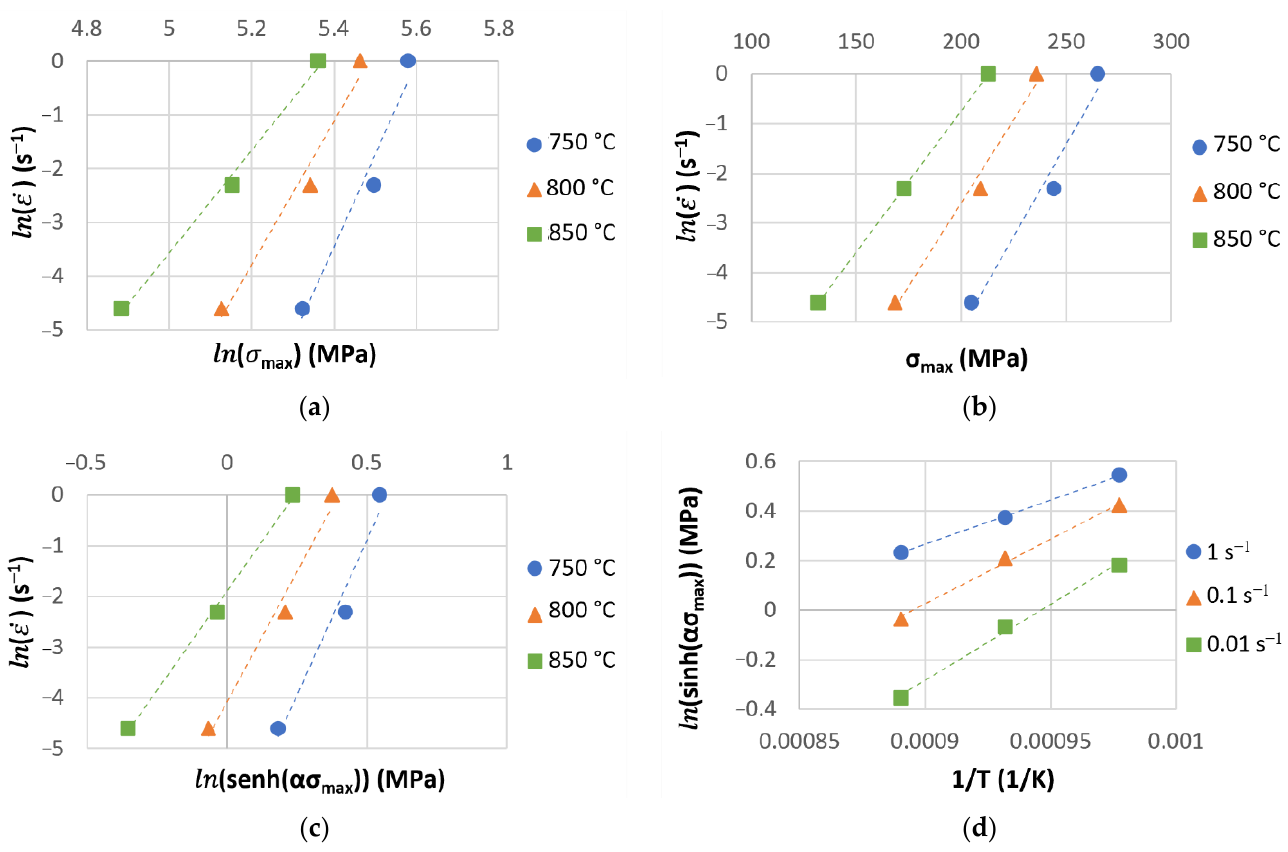
. Figure 21. Relationship between ( a ) 𝑙𝑛𝜀̇ and 𝑙𝑛𝜎 𝑚𝑎𝑥 at different temperatures, ( b ) 𝑙𝑛𝜀̇ and 𝜎 𝑚𝑎𝑥 at Figure 21. Relationship between ( a ) ln ε and ln σ max at different temperatures, ( b ) ln . different temperatures, ( c ) 𝑙𝑛𝜀̇ and 𝑙𝑛 (𝑠𝑒𝑛ℎ(𝛼𝜎 𝑚𝑎𝑥 ) at different temperatures, and ( d ) ε and ln ( senh ( ασ max ) at different temperatures, and ( d ) ln ( senh ( ασ max ) different temperatures, ( c ) ln 1 𝑙𝑛 (𝑠𝑒𝑛ℎ(𝛼𝜎 ) and and 1 at different strain at different strain rates. 𝑚𝑎𝑥 T 𝑇